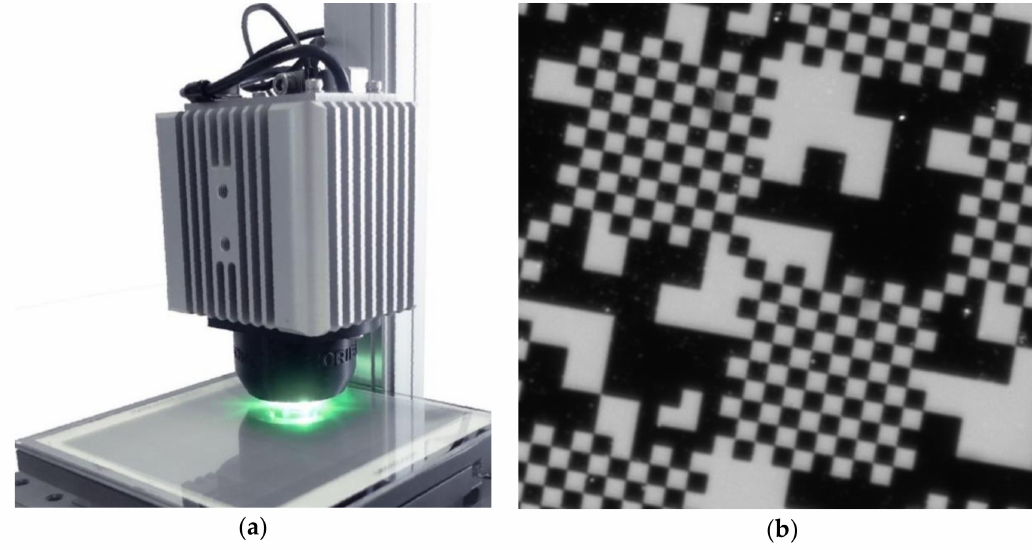
Figure 1. nanoGPS OxyO ® encoder. ( a ) photo of whole device including scale and read head; ( b ) detail of scale image taken by read